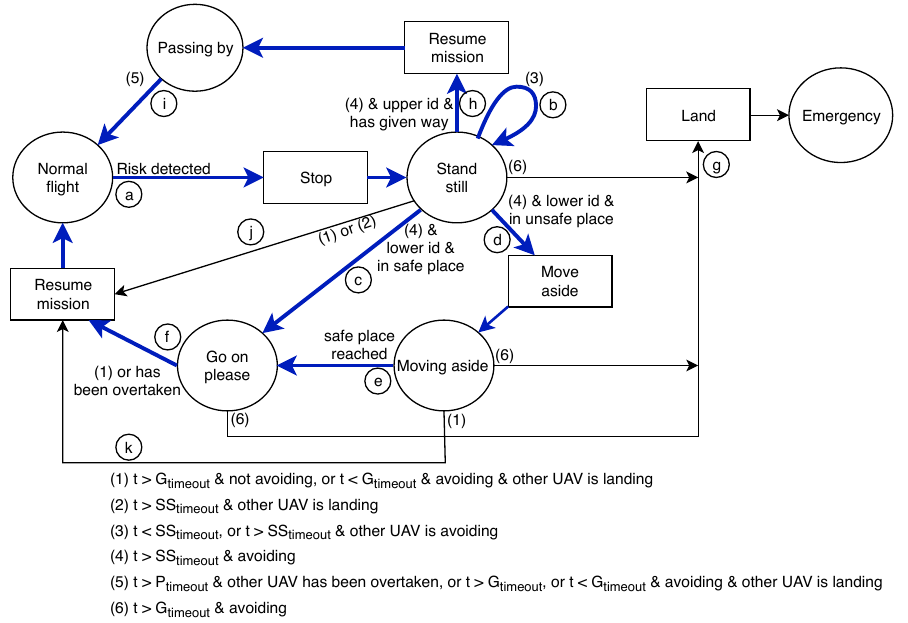
Figure 2. Mission Based Collision Avoidance Protocol-e (MBCAP-e) finite state